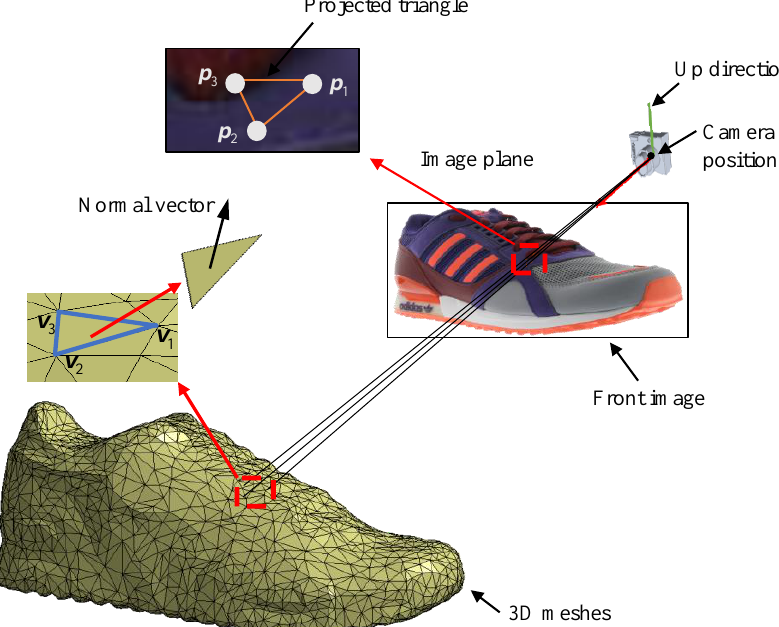
Figure 5. Texture